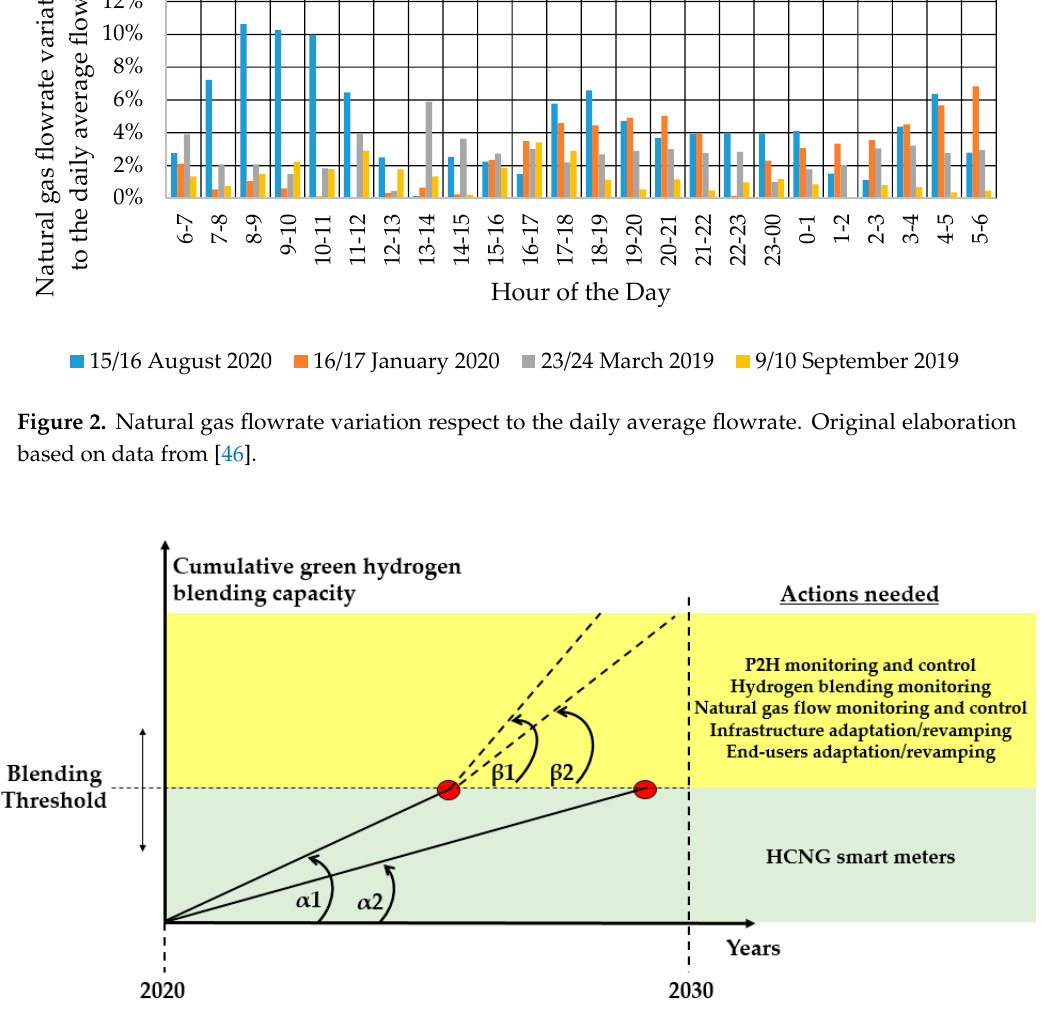
Figure 3. Design of the first phase of implementation of the hydrogen blending strategy.